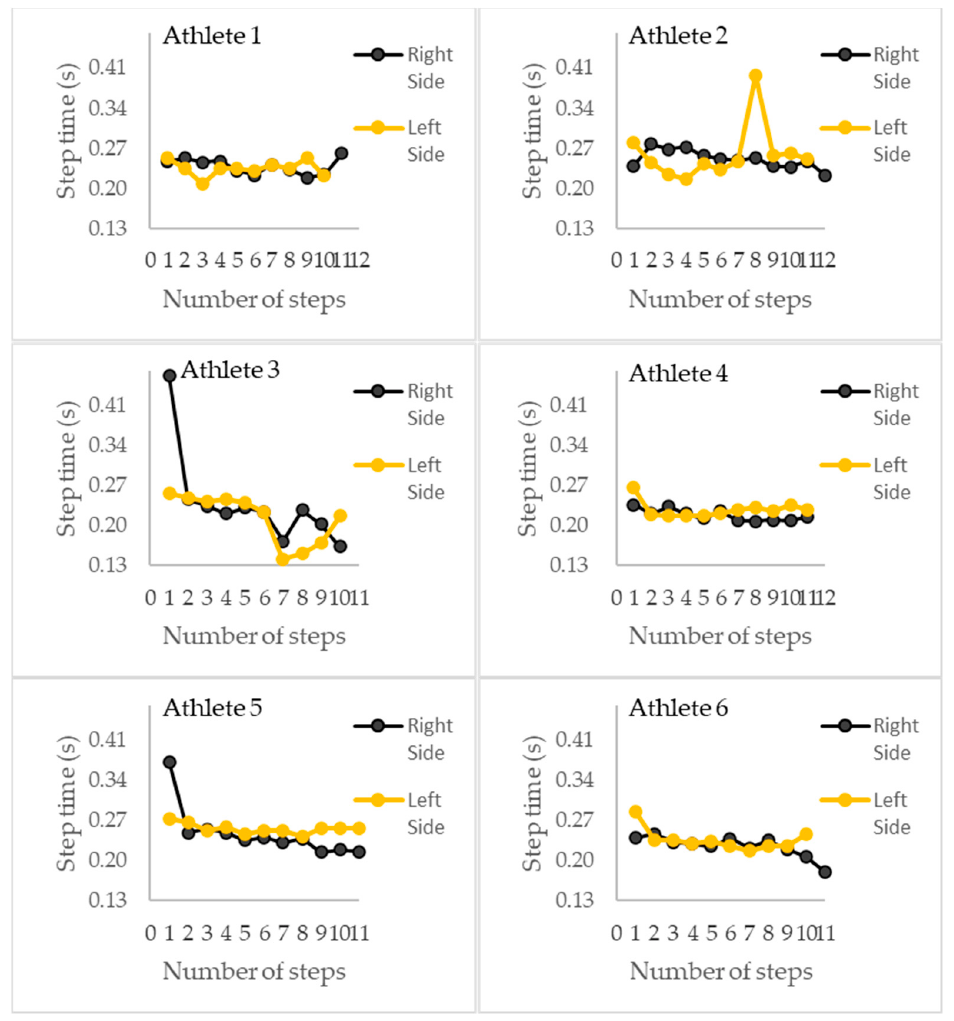
Figure 5. The step time comparison between the left and right sides, showing the best performance results over 40 m for athlete 1, athlete 2, athlete 3, athlete 4, athlete 5, and athlete 6.